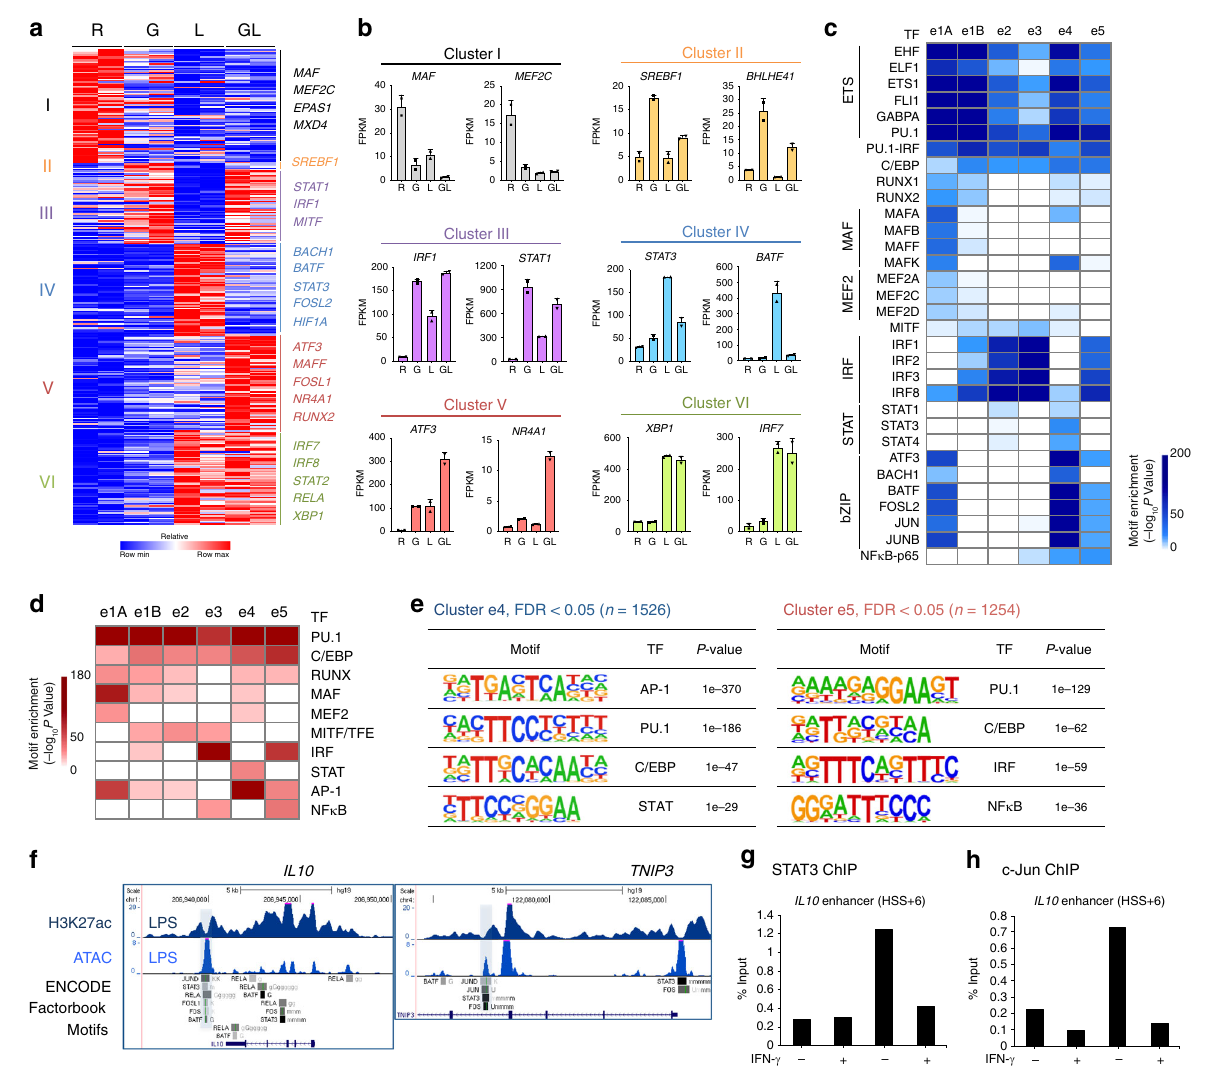
Fig. 3 TF expression and binding motif enrichment in distinct enhancer subsets. a Heatmap of gene expression of 91 transcription factors in the clusters de fi ned in Fig. 1a. b Examples of TF gene expression from the six identi fi ed clusters identi fi ed in a . c Heatmap showing the P -value signi fi cance of known motif enrichment in each cluster (de fi ned as in Fig. 2a) and grouped according to TF families (left). d Heatmap showing the P -value signi fi cance of de novo motif enrichment in six enhancer clusters. e The most signi fi cantly enriched transcription factor (TF) motifs identi fi ed by de novo motif analysis using HOMER in cluster e4 (left) and cluster e5 (right) enhancers. f UCSC Genome Browser tracks showing normalized tag density of H3K27ac ChIP-seq and ATAC-seq in LPS-stimulated macrophages. Cumulative TF binding at each e4 enhancer from ENCODE project (Factorbook) is shown below the gene tracks. Boxes enclose representative e4 enhancers at IL10 (left) and TNIP3 (right) locus. g ChIP-qPCR of STAT3 at the e4 enhancer (HSS + 6) of IL10 . h ChIP-qPCR of c-Jun at the e4 enhancer (HSS + 6) of IL10 . Data depict experiments with two different donors ( a ) or are representative of two ( b – f ) or three ( g , h ) independent